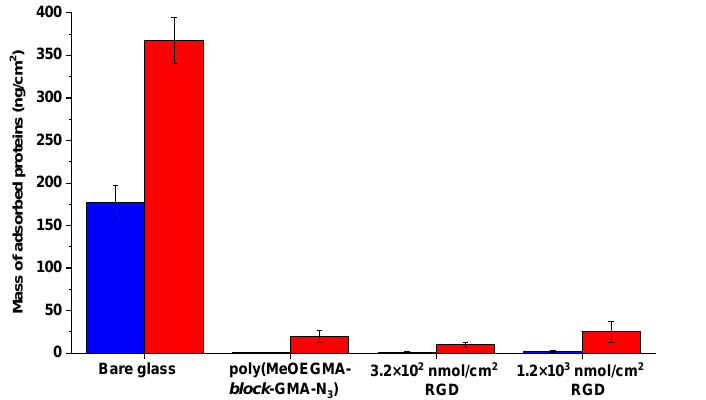
Figure 4. Comparison of the fouling from cell seeding medium (blue) and undiluted human blood plasma (HPB) (red): bare gold, poly(MeOEGMA- block -GMA-N 3 ) polymer brush before and after immobilization of RGD peptide of surface concentration 3.2 × 10 2 nmol/cm 2 and 1.2 × 10 3 nmol/cm 2 .